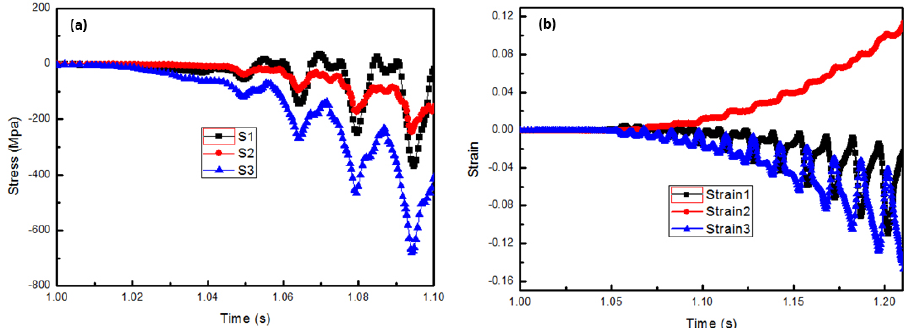
Figure 12. The stress ( a ) and strain ( b ) distribution of P5.